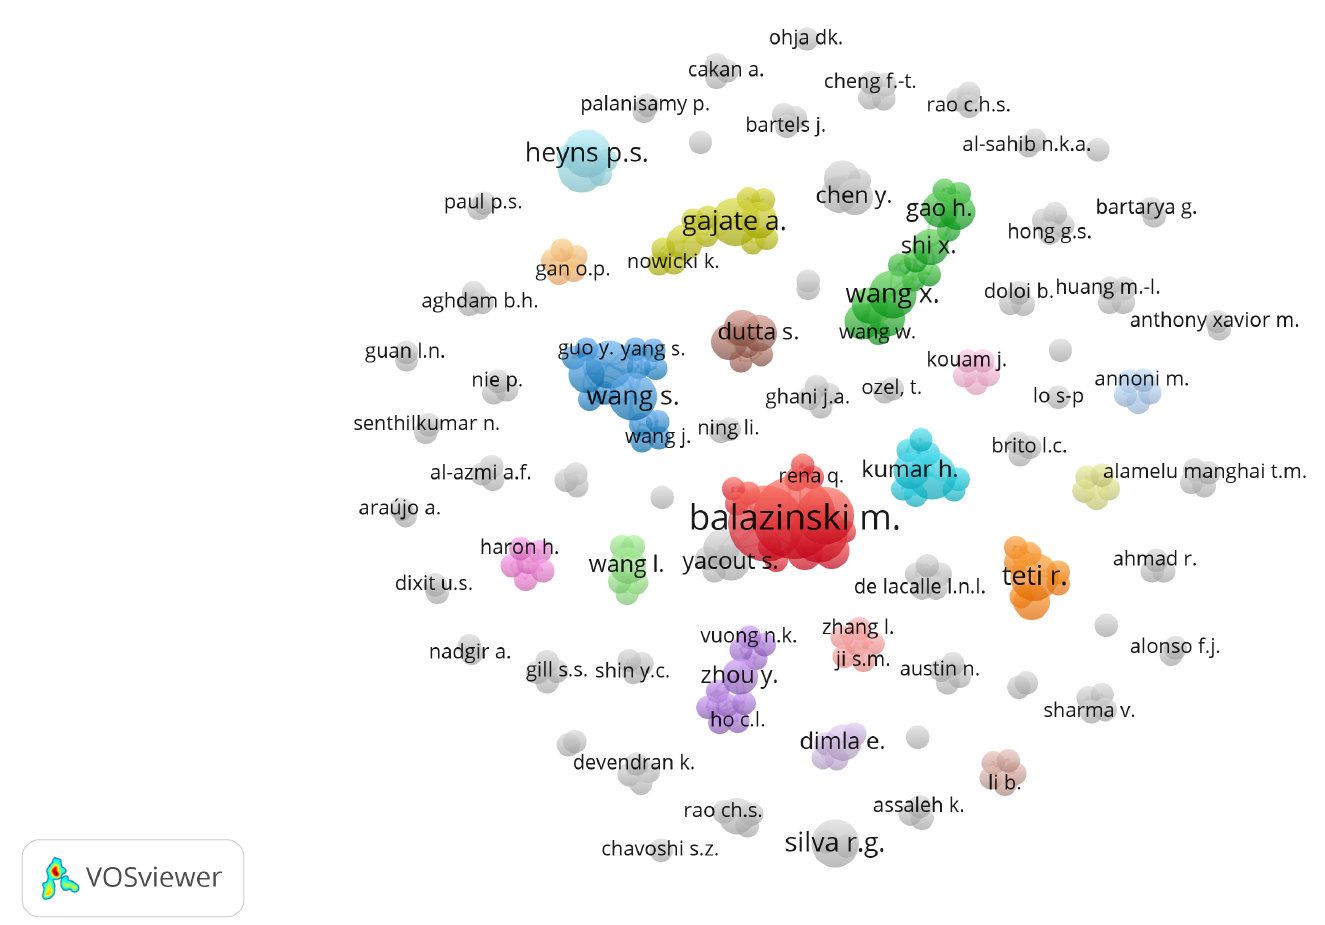
Figure 7. Author mapping using